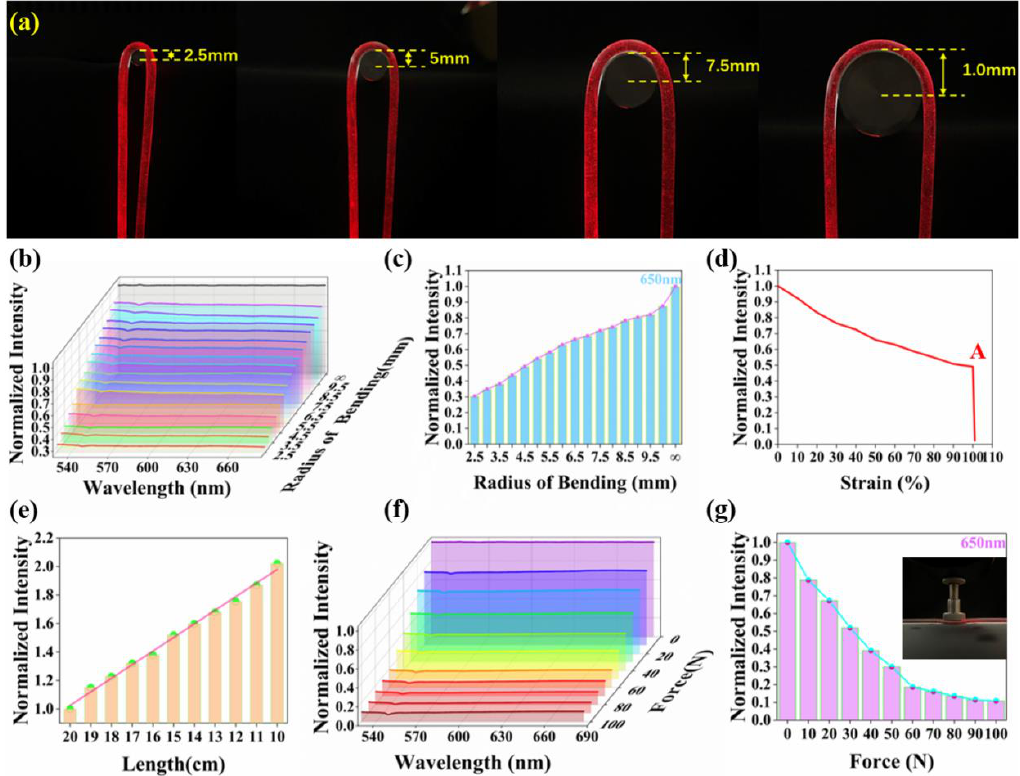
Figure 3. Mechanical and optical properties of elastic fibers. ( a ) Physical diagrams of U-shaped optical fiber with different bending radii. ( b ) Optical transmission changes of optical fibers under different bending radii. ( c ) The bending radius-normalized light intensity relation diagram at 650 nm. ( d ) Strain-normalized intensity curve of elastic fiber at 650 nm. ( e ) Propagation loss of elastic fiber, measured in air by cutback method. ( f ) The curves of optical transmission of the fiber subjected to a lateral pressure of 0 to 100 N. ( g ) The pressure-normalized light intensity relationship diagram at 650 nm.